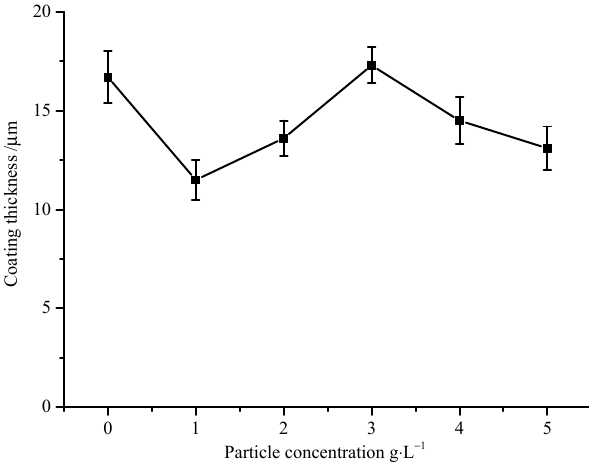
Figure 5. Curve of particle concentration and thickness of the composite coating.